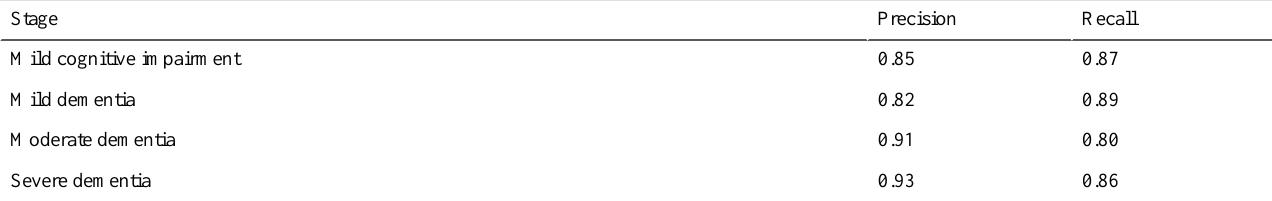
Table 4. Precision and recall of model prediction by dementia